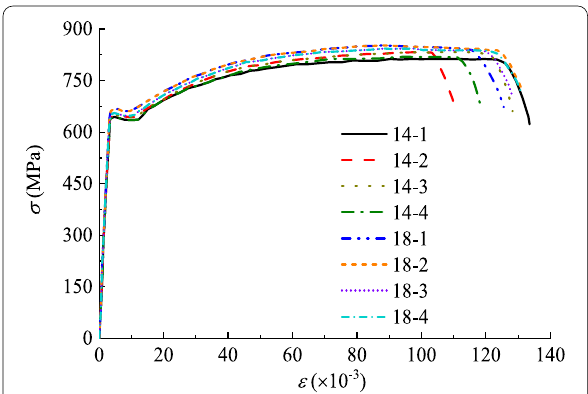
Fig. 1 Experimental stress–strain curves of 600 MPa steel bars.